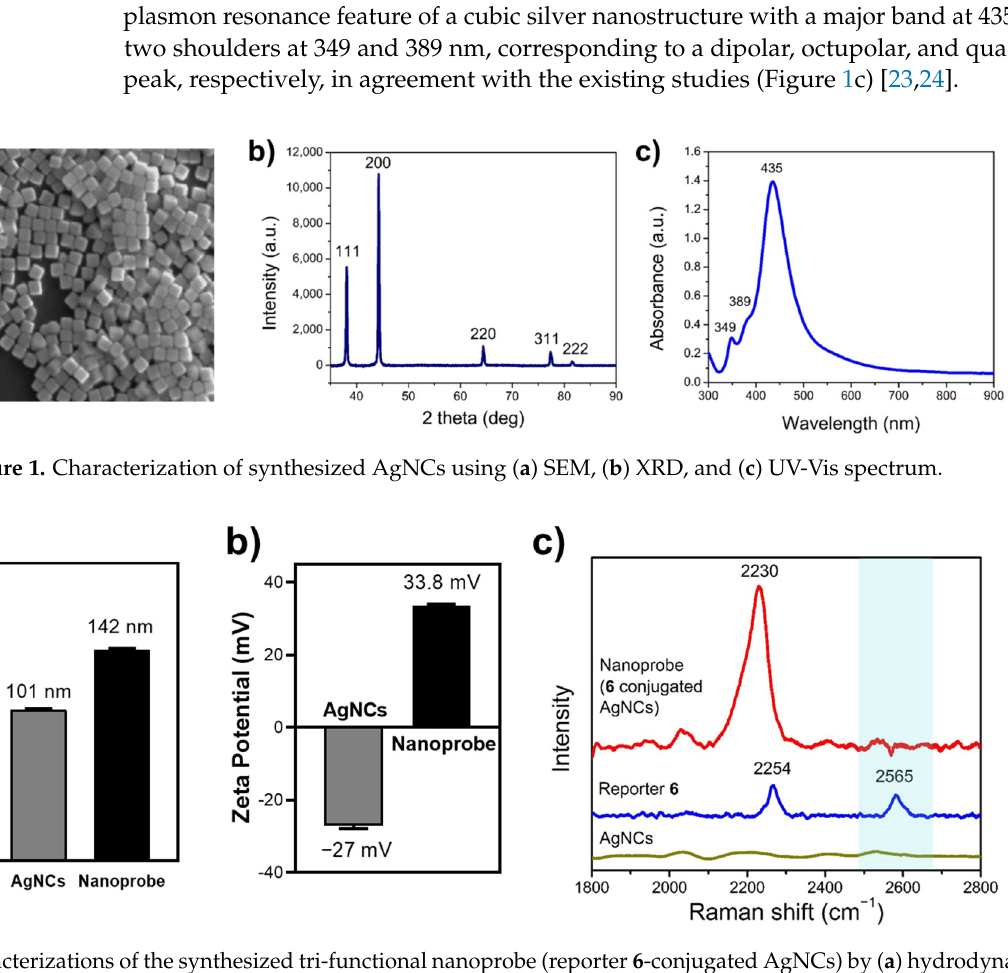
Figure 2. Characterizations of the synthesized tri-functional nanoprobe (reporter 6 -conjugated AgNCs) by ( a ) hydrodynamic size, ( b ) zeta potential, and ( c ) SERS measurement (at λ = 532 nm, 0.78 mW, 100× objective lens, exposure time of 5 s).